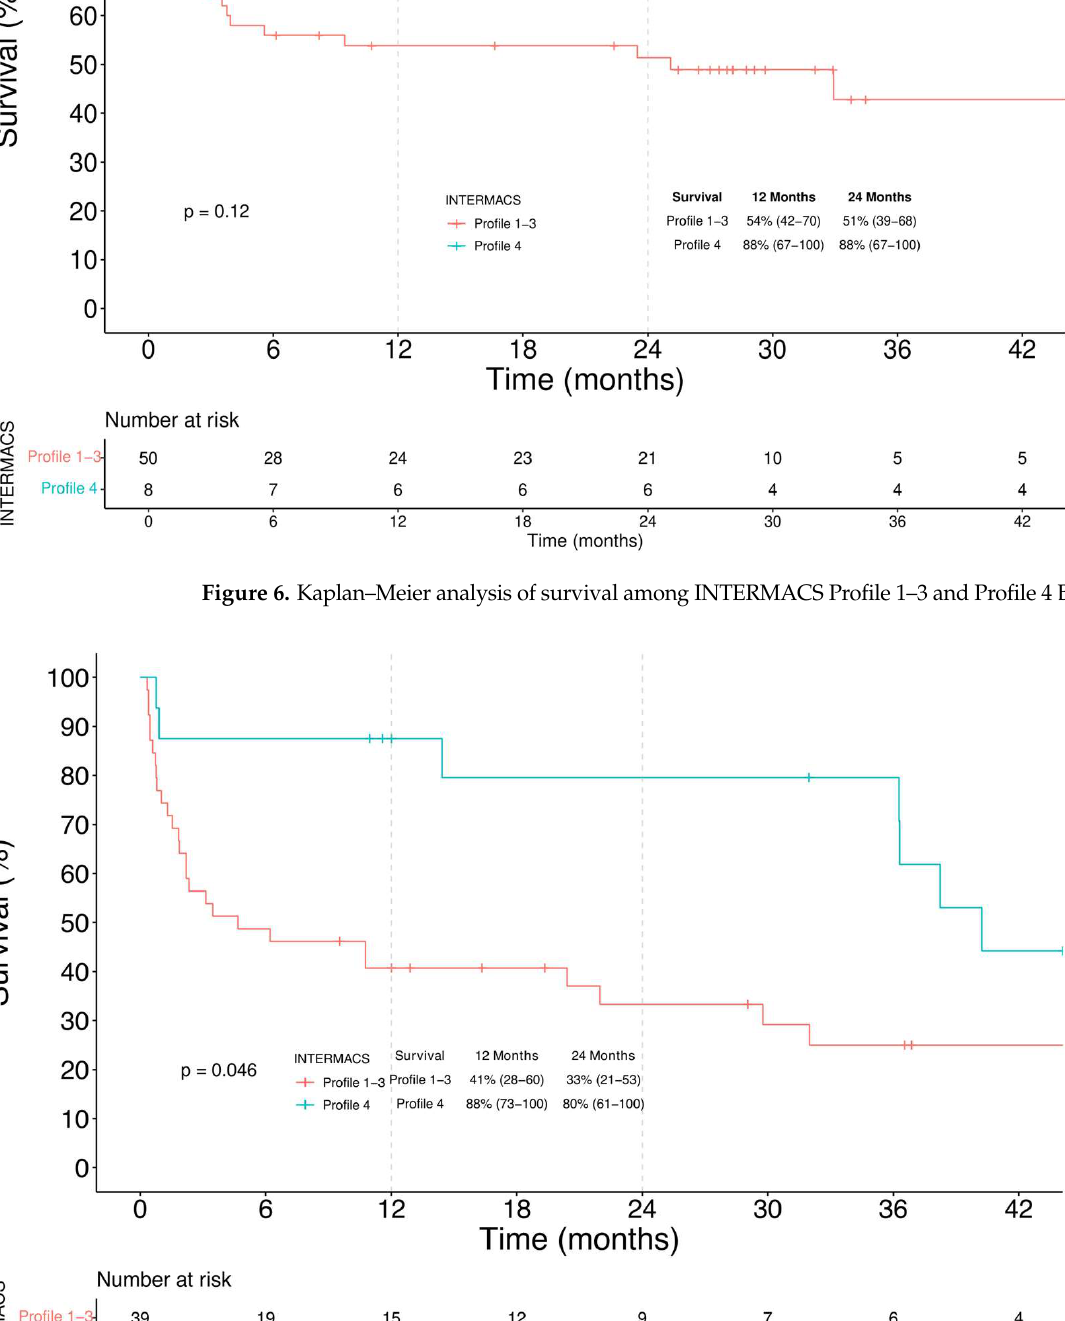
Figure 7. Kaplan-Meier analysis of survival among INTERMACS Profile 1–3 and Profile 4 DT patients.